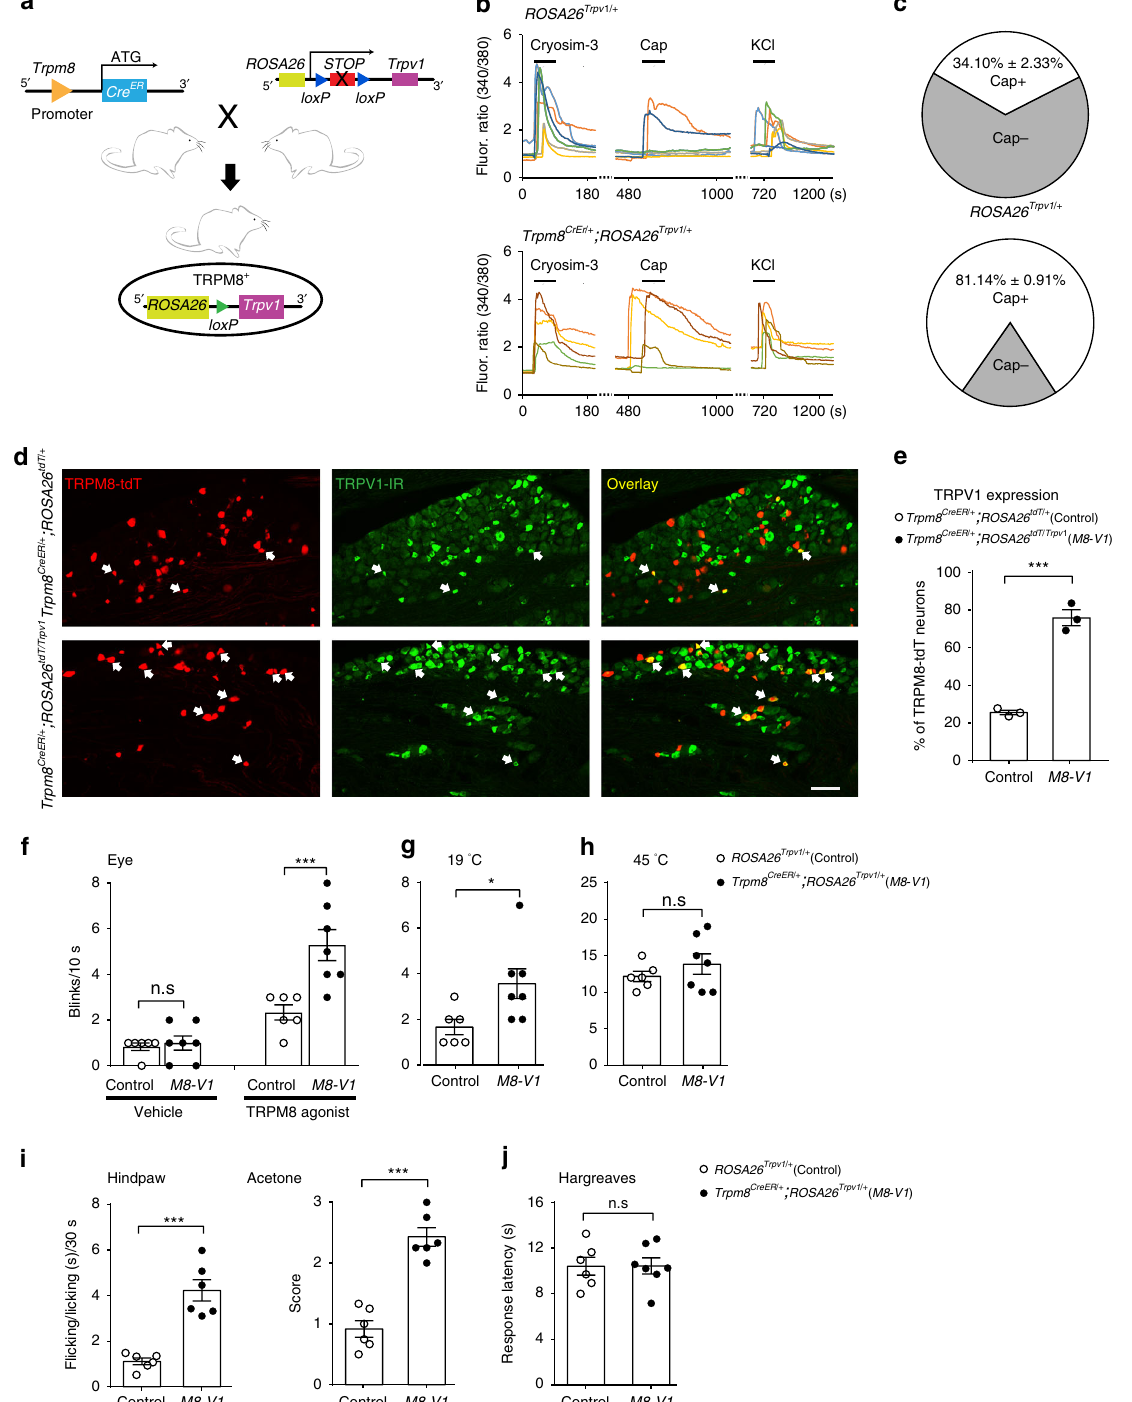
nociception, we investigated the potential neurotransmitters/ neuromodulators in signaling ocular cold nociception. We rea- nalyzed one previously published dataset of TG neuronal tran- scriptional pro fi les at the single cell level (GEO database, accession number GSE101984) 25 . In addition to vesicular gluta- mate transporter 2, substance P (encoded by Tac1 gene) is unexpectedly highly expressed by a majority of TRPM8 + neurons in TG (Fig. 7a and Supplementary Fig. 10). To con fi rm the expression of substance P in corneal sensory neurons, we manually picked TG neurons that were retrogradely labeled by